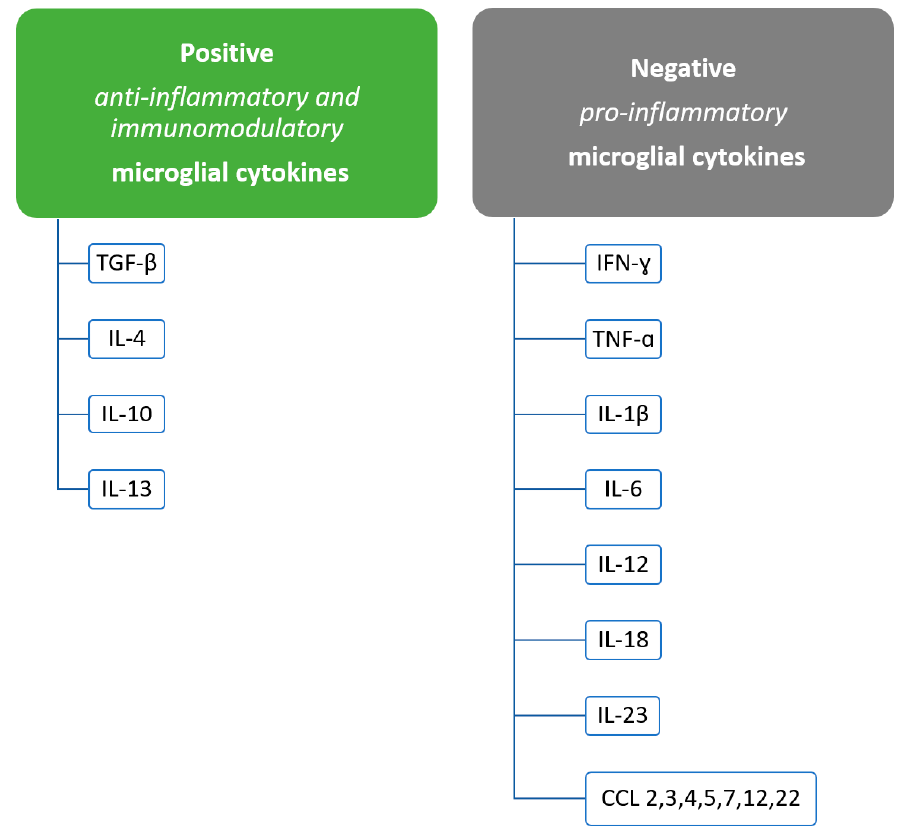
Figure 2. Division of microglial cytokines depending on their positive or negative effects in the pathogenesis of MS.